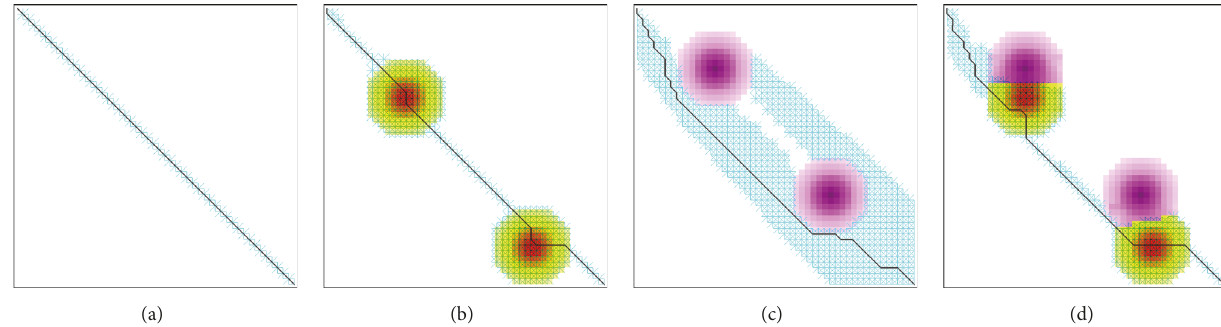
Figure 6: Finding a path (in black) from the top-left node to the bottom-right node of a 50 × 50 grid using influence-aware A ∗ algorithm (A ∗ T): (a) without attractors and repulsors, the search space only covers neutral nodes (in cyan) along or close to the path (in black); (b) with 2 attractors, the search space substantially reduces itself to neutral nodes (in cyan) along the path and attractor nodes (in red-to-yellow blended with cyan) provided that they are on the way to the goal node; (c) with 2 repulsors, the search space also substantially reduces itself to neutral nodes (in cyan) along the path, as the interior nodes of repulsors were not visited; (d) with 2 attractors and 2 repulsors, the search space is again limited to neutral nodes (in cyan) and attractor nodes (in red-to-yellow blended with cyan) along the path, with repulsor nodes (in purple blue) not being visited. Nodes in cyan or blended with cyan represent visited nodes, that is, nodes in the open and closed lists.